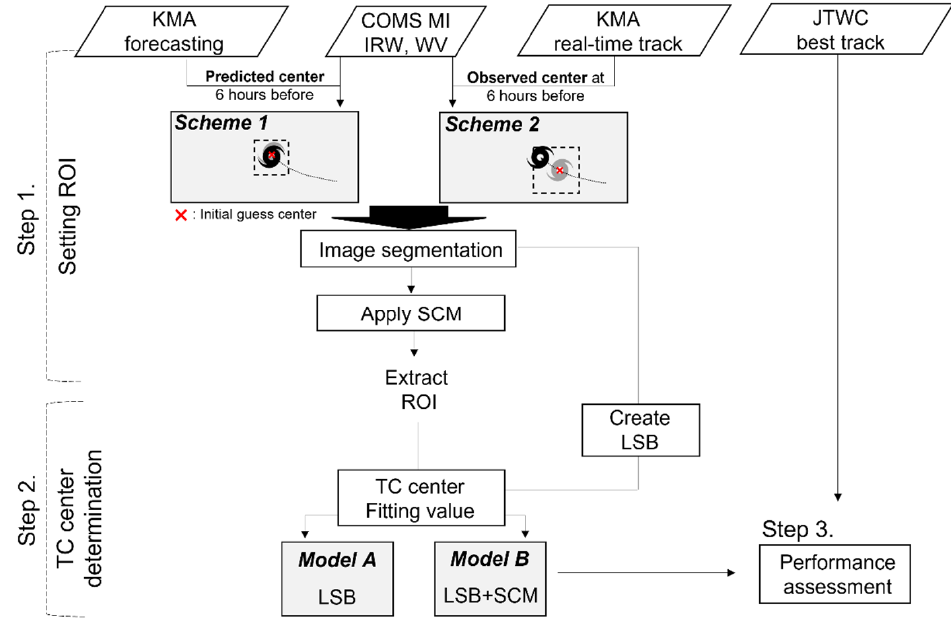
Figure 2. Flow chart of the proposed TC center estimation approach.